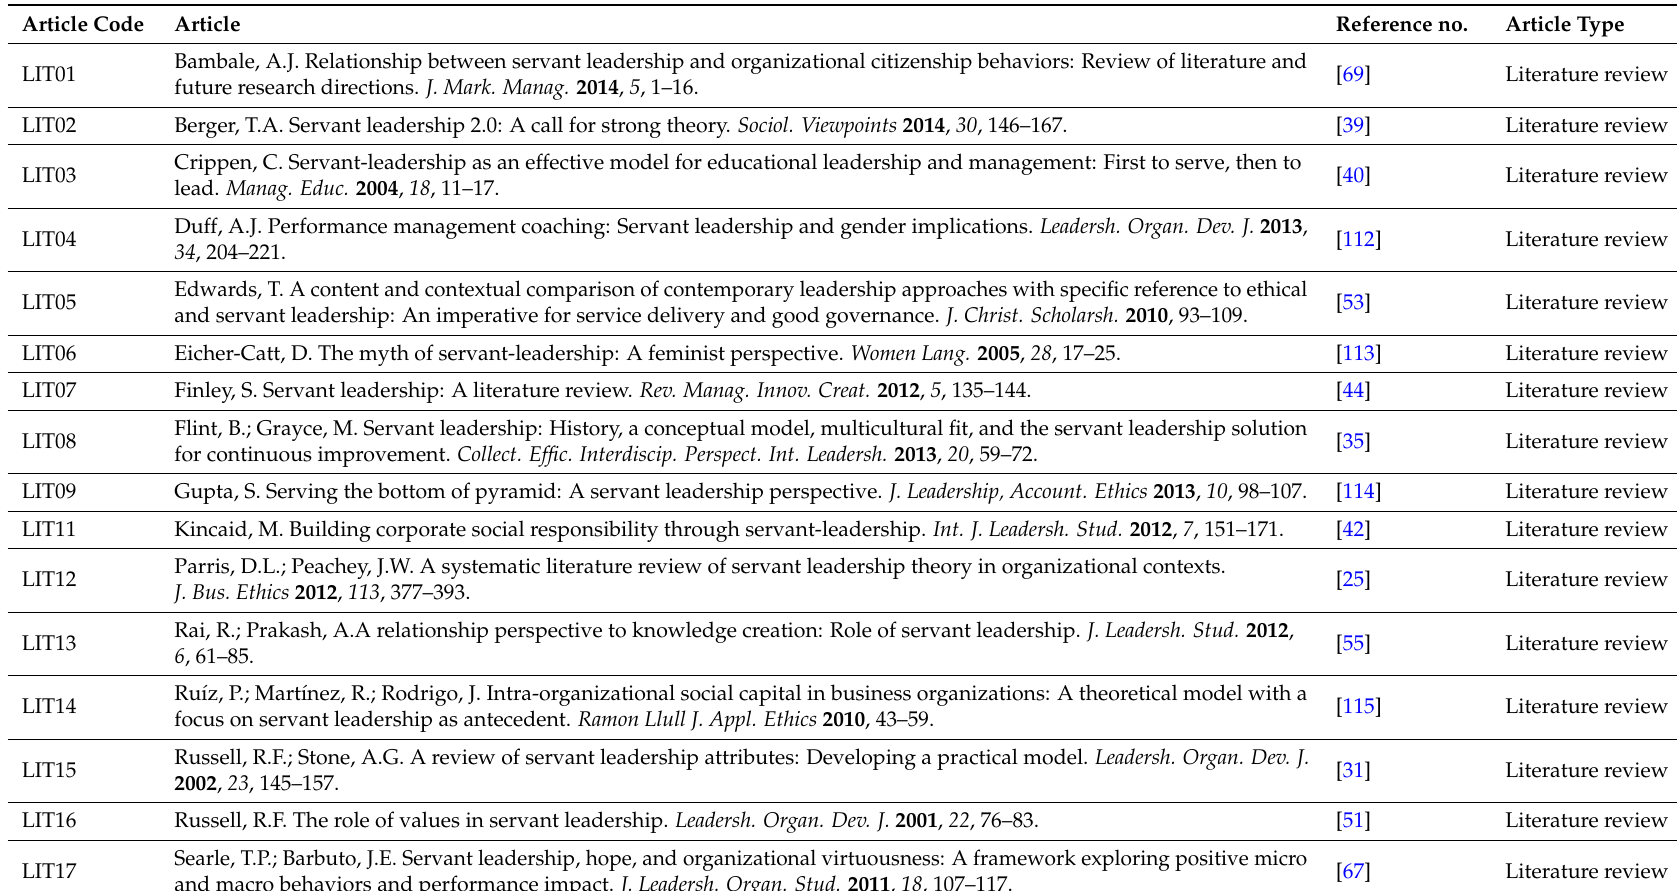
Table A1. List of final